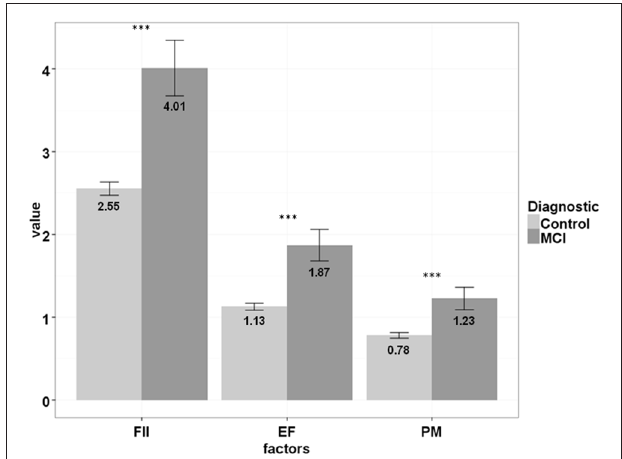
FIGURE 2 | EQM-10 factors scores differences between controls and MCIs. Note. MCI, Mild Cognitive Impairment; FII, Forgetfulness of Immediate Information; EF, Executive Functions; PM, Prospective Memory. ∗∗∗ p -value < 0.001.